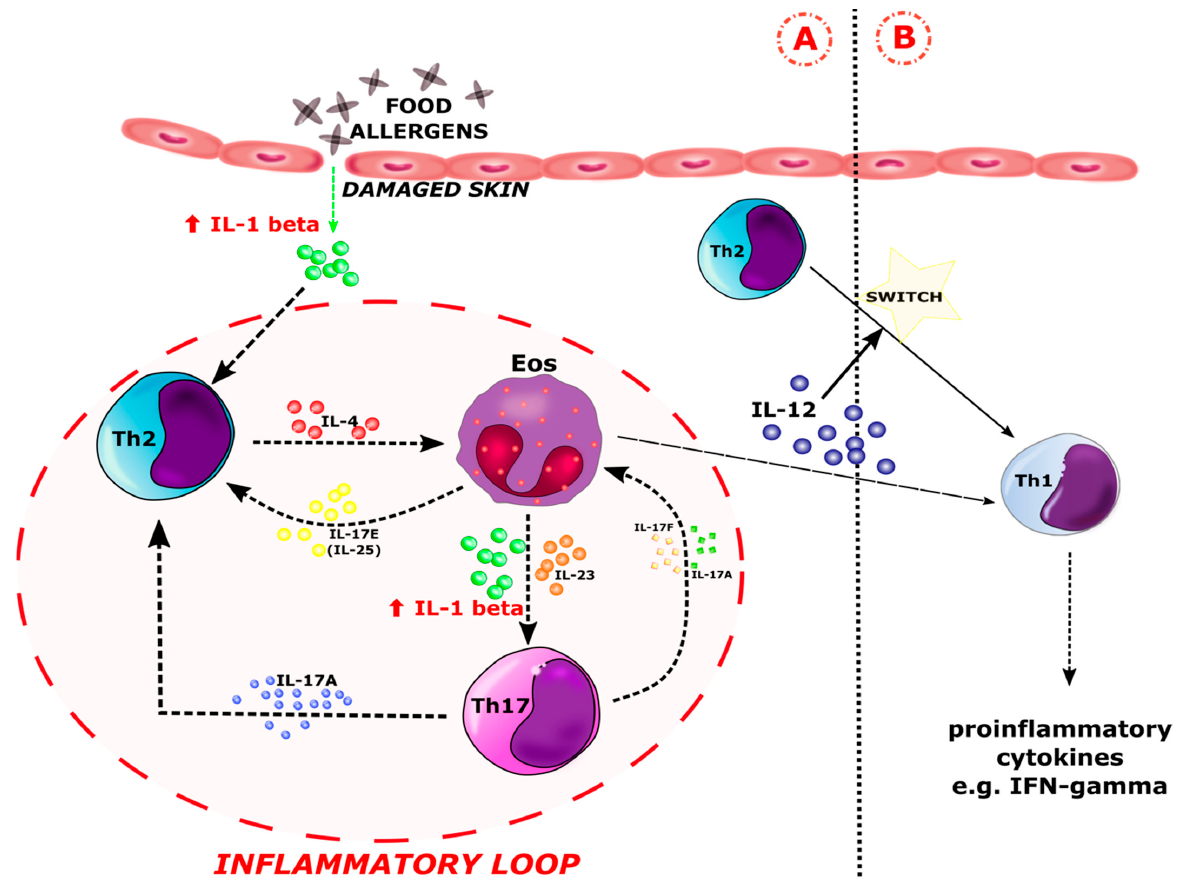
clinical and pathological similarities.